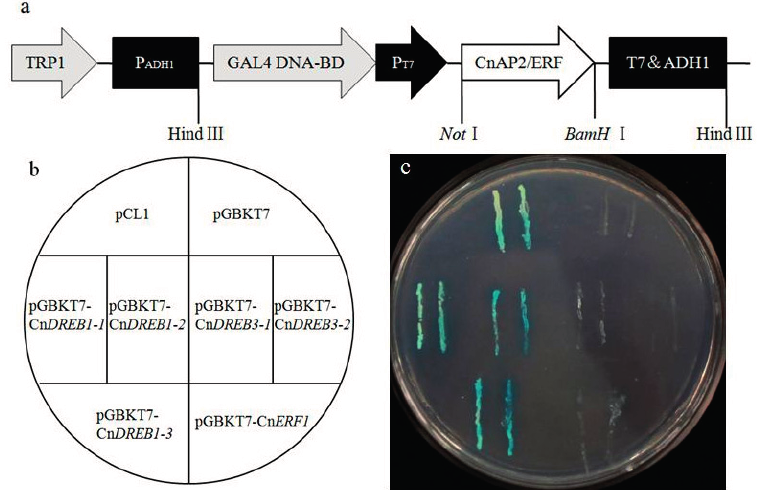
Figure 3. Transcriptional activation activity of the CnAP2/ERF TFs. ( a ) The structure of the pGBKT7-CnAP2/ERF plasmid; ( b ) the arrangement of yeast strains on the plate; ( c ) the growth of transformed yeast cells on SD/-His-Ade + 20 mg/mL X- α -gal medium. pCL1 and pGBKT7 are positive and negative controls,